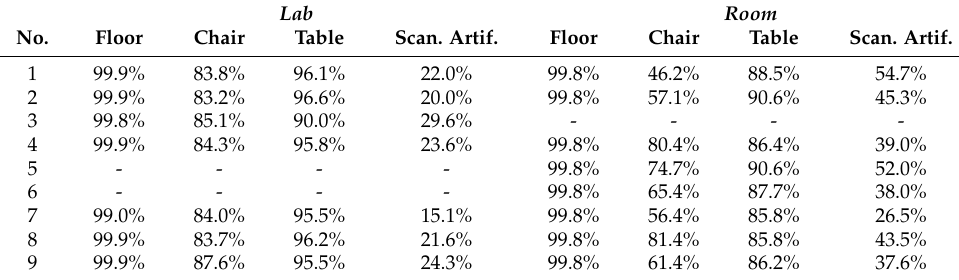
Table A8. Recall for the datasets Lab and Room , semantically segmented by PCCTI . Lab Room No. Floor Chair Scan. Artif. Floor Chair Scan. Artif.